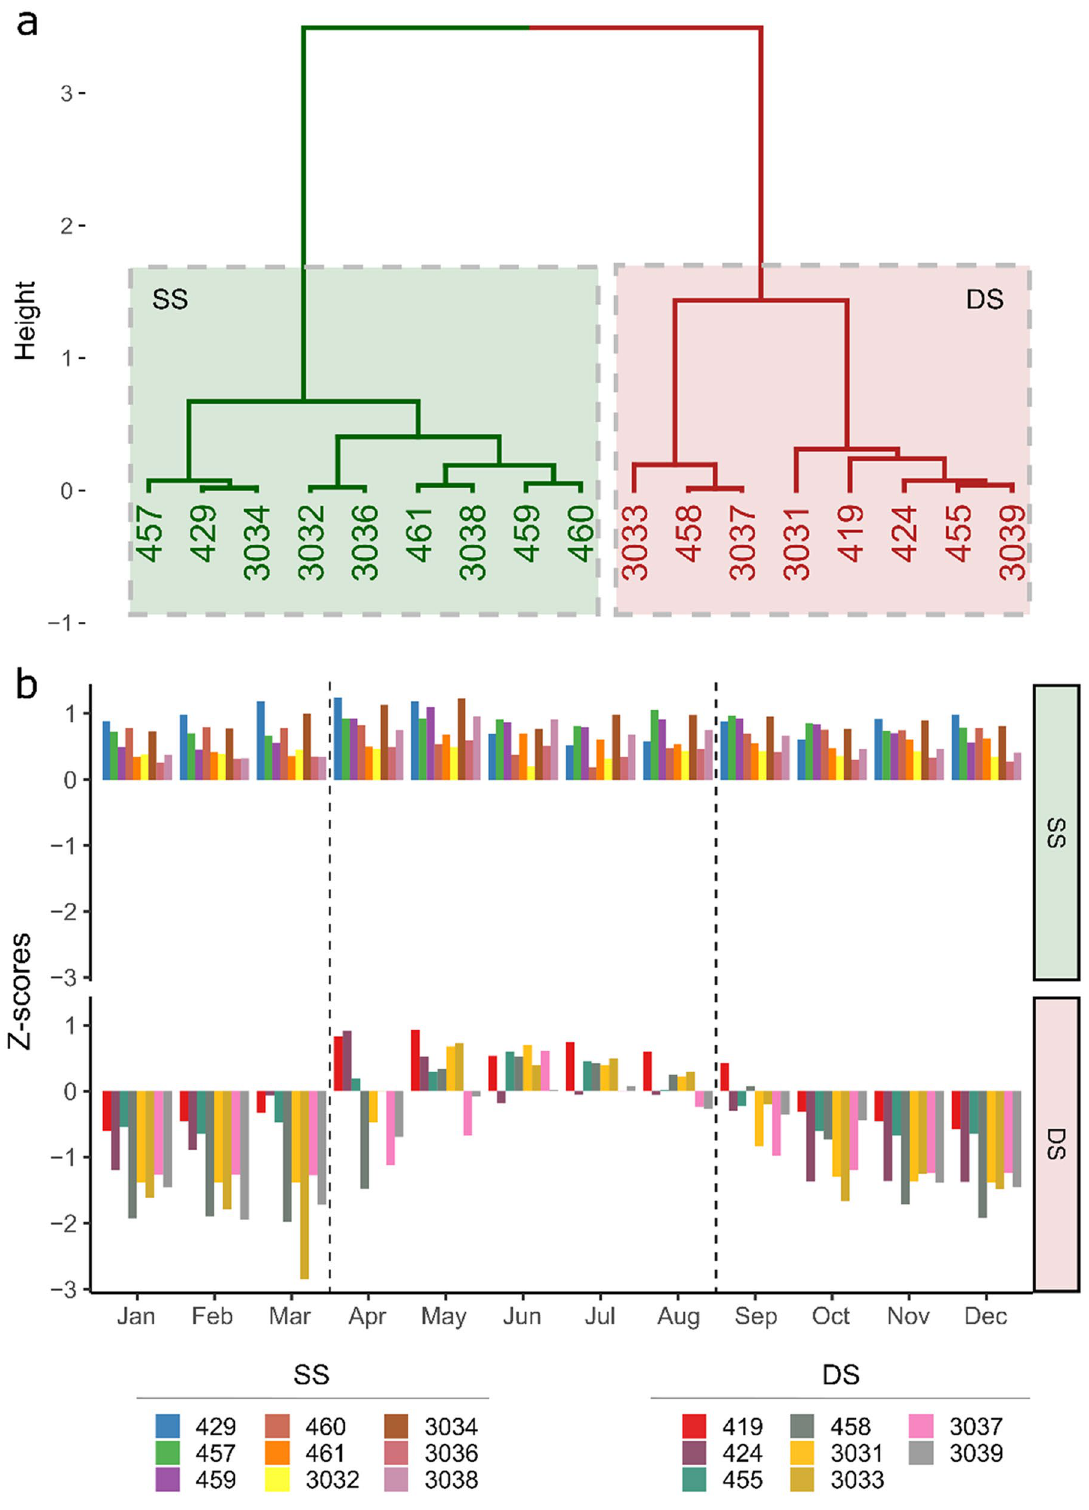
Figure 3. Definition of fish groups and periods. ( a ) Clustering analysis on the total mean fish depth Z-scores, identifying two fish groups ( SS shallow/shallow, DS deep/shallow) and ( b ) monthly mean of fish depth Z-scores (all years included) to define two periods, delimited by dashed lines (Warm: April to August and Cold: January to March and September to December). Numbers represent the fish identification